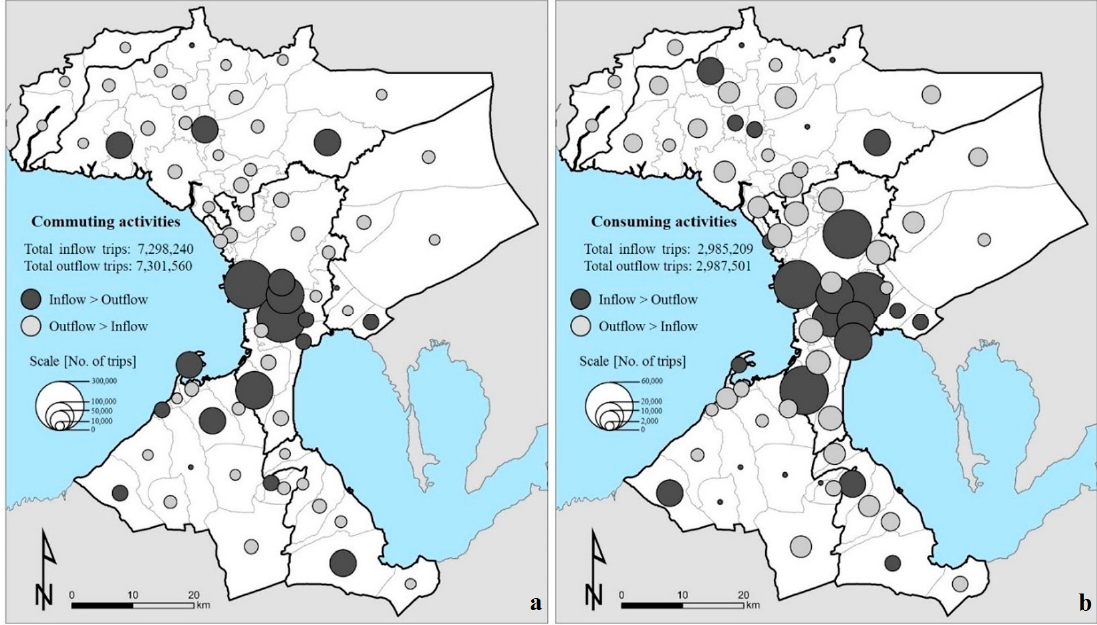
Figure 4. Inflow/outflow excess trips for commuting activities ( a ) and consuming activities ( b ).